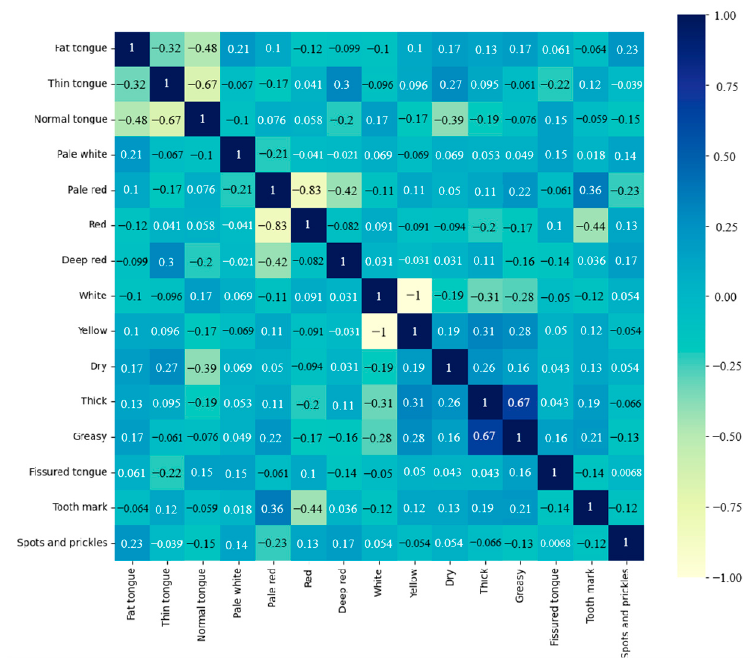
Figure 6. Correlation between tongue features in the gastric cancer group.